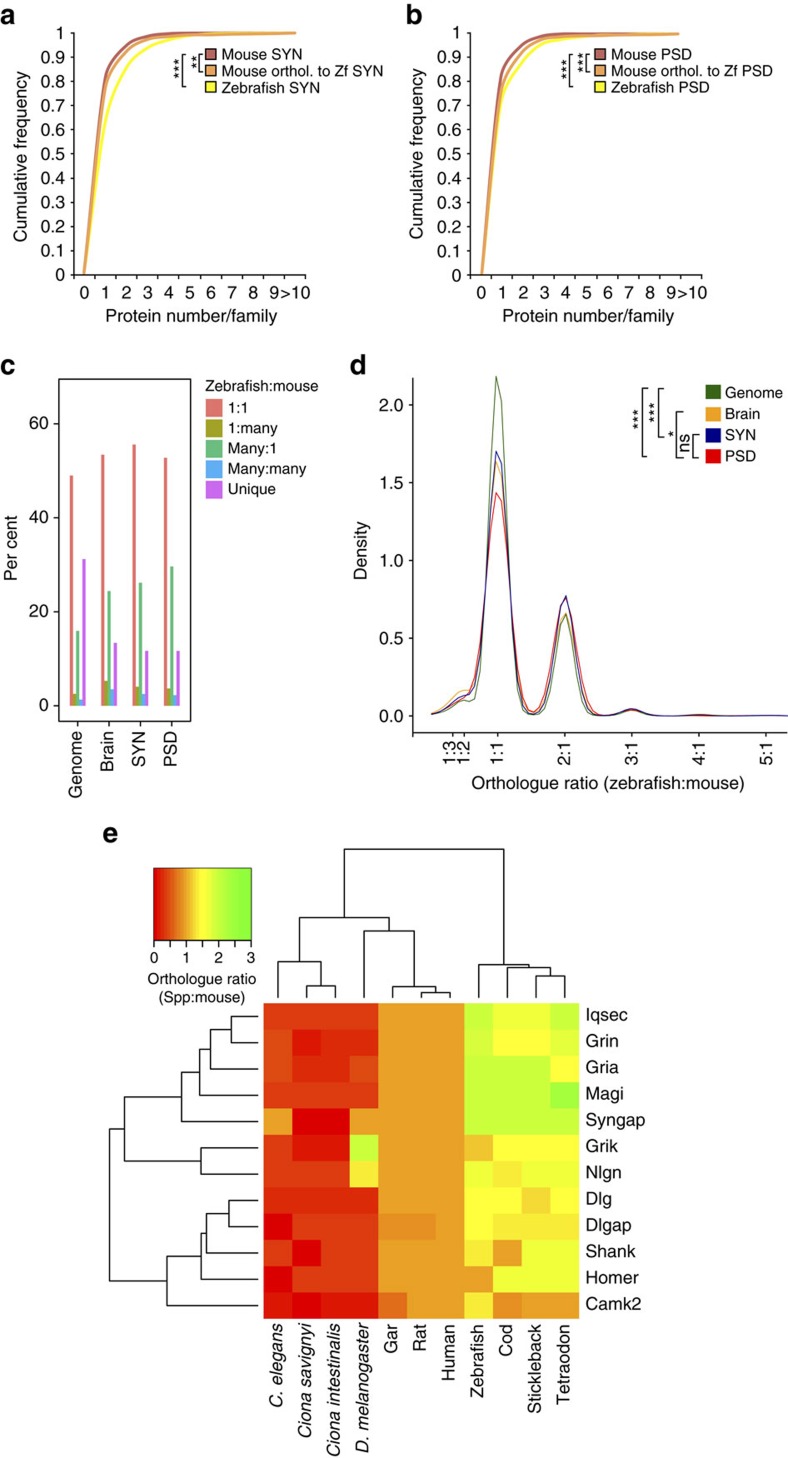
Expansion and retention of synaptic proteins after teleost-specific whole-genome duplication.(a) Cumulative frequency plot of proteins found per Ensemble Family among mouse, zebrafish and mouse orthologues of zebrafish SYN proteins. Kruskal–Wallis test was used to calculate significance between distributions (**P<0.01 and ***P<0.0001). (b) Cumulative frequency plot of proteins found per Ensembl Family among mouse, zebrafish and mouse orthologues of zebrafish PSD proteins. Kruskal–Wallis test was used to calculate significance between distributions (**P<0.01 and ***P<0.0001). (c) Distribution of orthology types between zebrafish and mouse. For each protein in the proteome, the corresponding gene was identified and orthologous genes between species were determined using the biomaRt bioconductor package67. For each gene the zebrafish:mouse ratio of orthologues was determined and characterized as 1:1, 1:many, many:1, many:many or was unique to mouse or zebrafish. (d) Density of proteome by orthologue ratio (zebrafish:mouse). Statistically significant comparisons between pairs of distributions (two-tailed Kolmogorov–Smirnov test applied to distributions) are shown. ***P<0.001 and *P<0.05; nonsignificant comparisons are not shown. (e) A heatmap representation of homologue ratio between mouse and each species for key synaptic gene families. For each gene family and species the homologues of mouse genes were identified using the biomaRt bioconductor package67. Colours represent the relative expansion (yellow–green) or reduction (red) of gene families compared to the size seen in mouse. Orange represents a 1:1 ratio where family size is equal in mouse and other species. Dendrograms show the similarity of species and gene families.